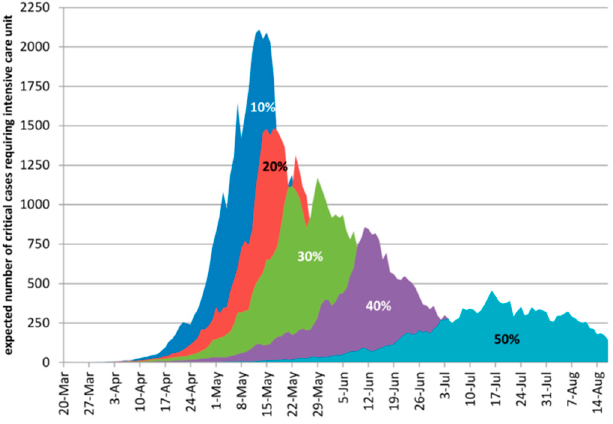
Figure 8. Expected cumulative COVID-19 cases requiring intensive care in Buenos Aires (according to different forms of intervention) [33].